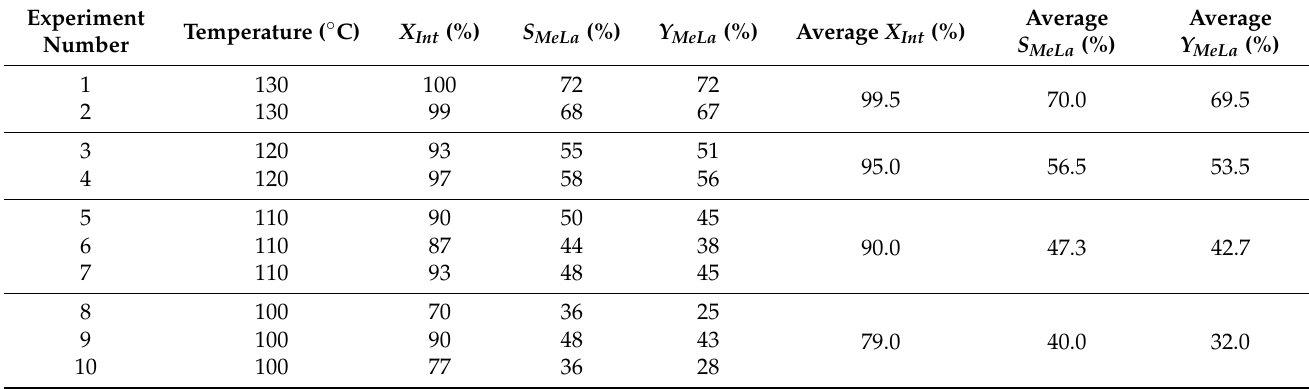
Figure 2. 1 H NMR (CDCl3, 400 MHz) stacked spectra of a methanolysis reaction at 120 °C and the relative percentage of each methine Int, CE, and MeLa (blue spectrum 11 min, red spectrum 60 min, green spectrum 140 min). Table 4. PLA methanolysis at 300 rpm with 0.05 g DMAP and 0.05 g ZnAc, conversion of Int groups, MeLa selectivity, and MeLa yield at different reaction temperatures.